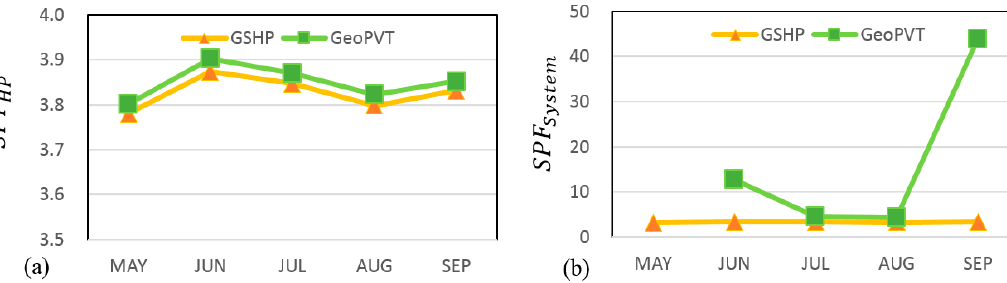
Figure 24. The result of SPF during daytime operation in cooling season. ( a ) Heat pump; ( b ) system.